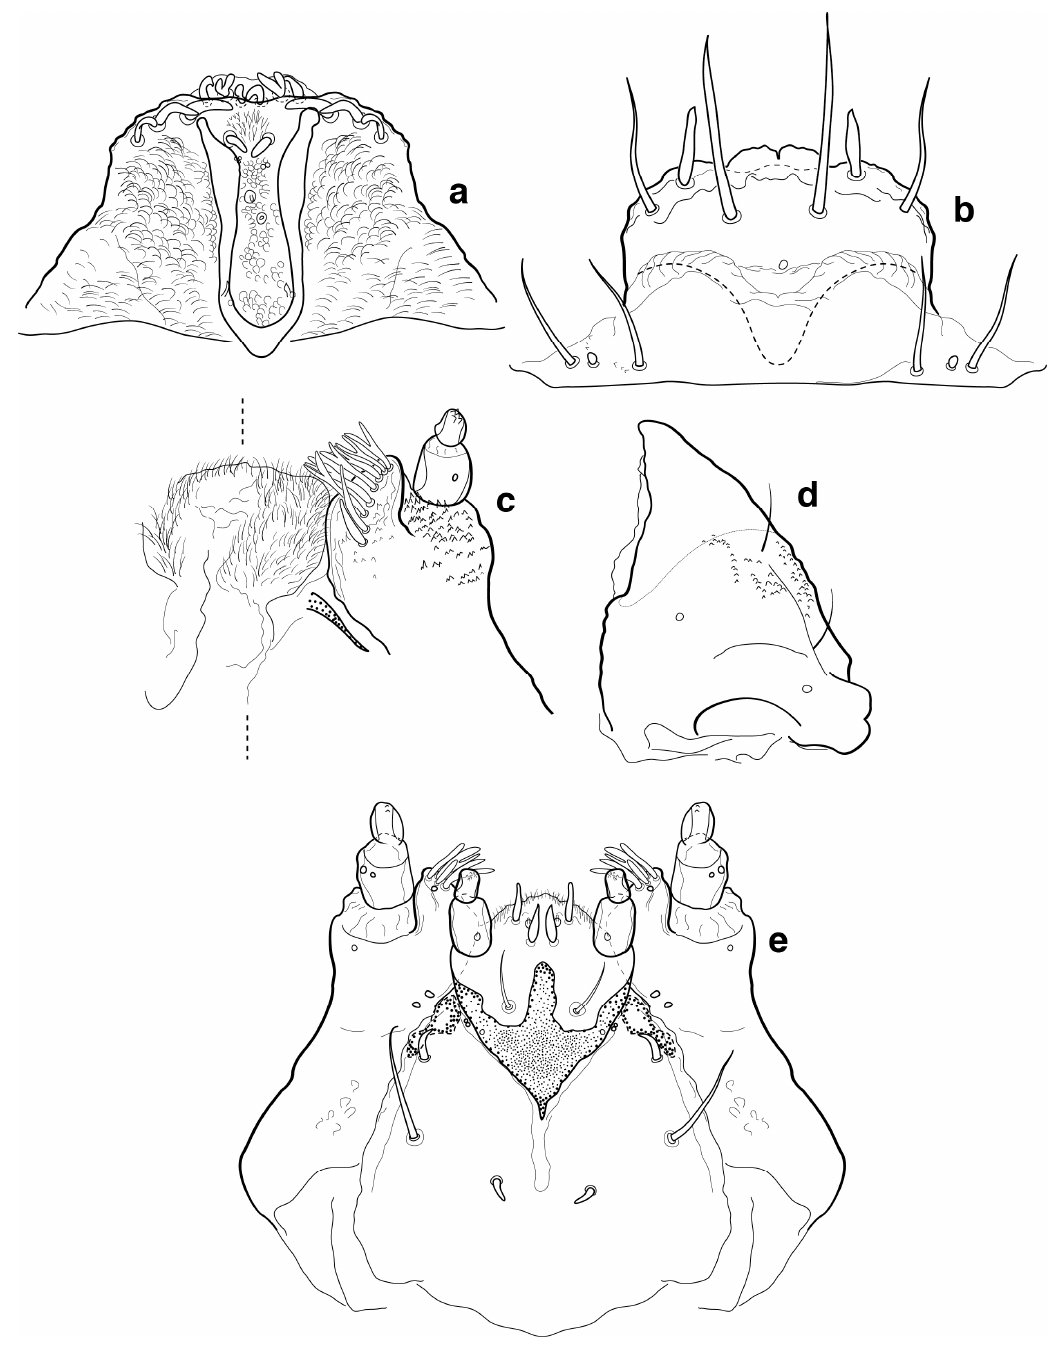
Figure 89. Trochorhopalus strangulatus mouthparts: ( a ) epipharynx; ( b ) clypeus and labrum; ( c ) detail of hypopharynx, mala, and maxillary palp, dorsal view; ( d ) mandible; and ( e ) labio-maxillary complex, ventral view.